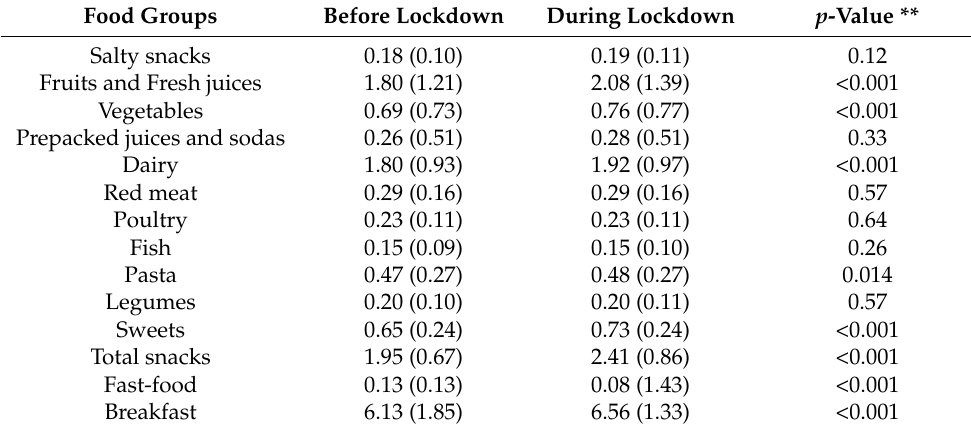
Table 4. Changes of children’s * and adolescents’ eating habits in the first COVID-19 lockdown in Greece. The COV-EAT study.